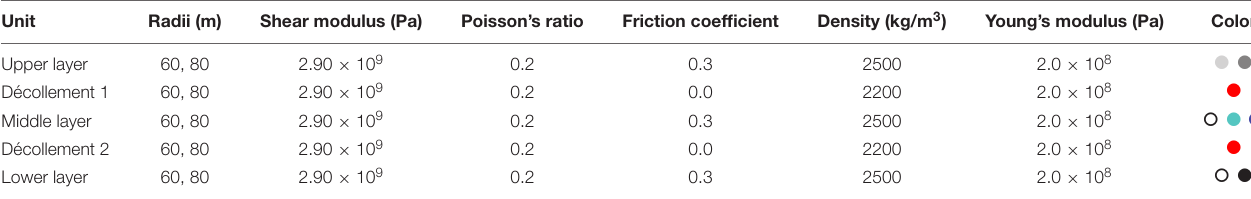
FIGURE 3 | Initial model setup. TABLE 1 | Parameter setting for the DEM